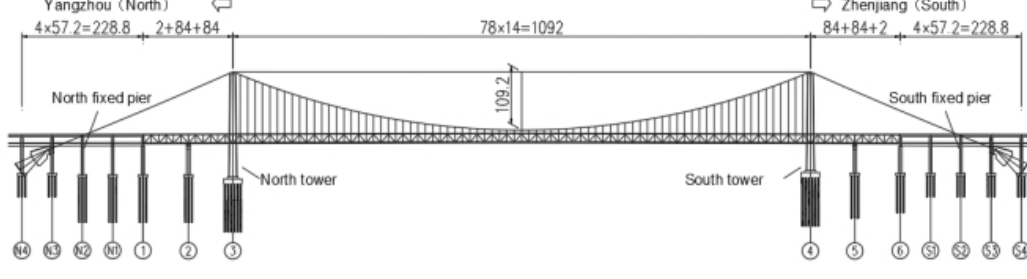
Figure 1. Elevation layout.